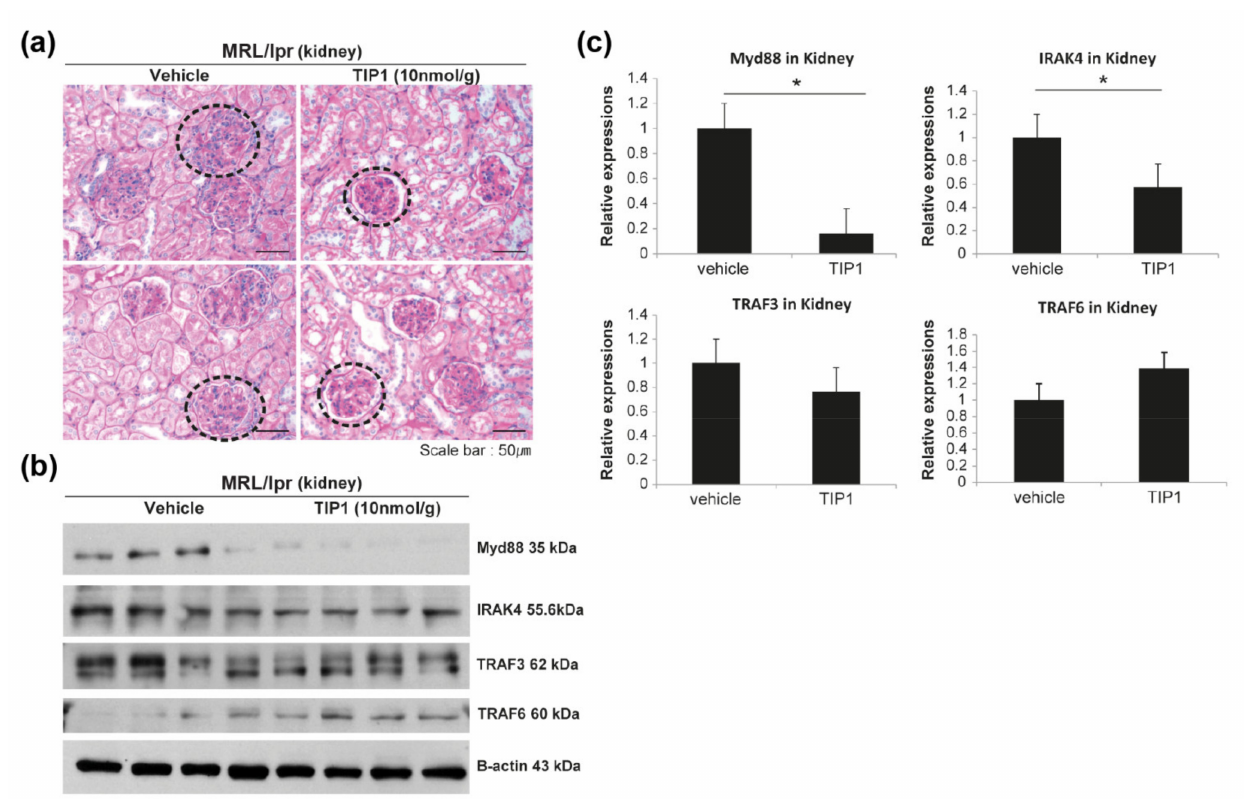
Figure 3. Toll-like receptor inhibitor peptide 1 (TIP1) improved nephritis in lupus-prone mice. ( a ) Periodic acid–Schiff (PAS) staining in the kidneys treated with TIP1. Representative microphotographs from PAS staining of the kidney tissues showing mesangial cell population, endothelial cell proliferation, and inflammatory cell infiltration around the glomerulus of lupus-prone mice (MRL/ lpr ; left panel, vehicle group; right panel, TIP1-treated group). n = 5 mice/group. ( b ) The total expression levels and ( c ) quantitative densitometry of endosomal Toll-like receptor signaling proteins in kidney tissues (n = 4 mice/group). * p < 0.05 by Mann–Whitney U test. The experiments were repeated at least twice. MyD88, myeloid differentiation factor 88; IRAK4, interleukin-1 receptor-associated kinase 4; TRAF3, tumor necrosis factor receptor-associated factor 3; TRAF6, tumor necrosis factor receptor-associated factor